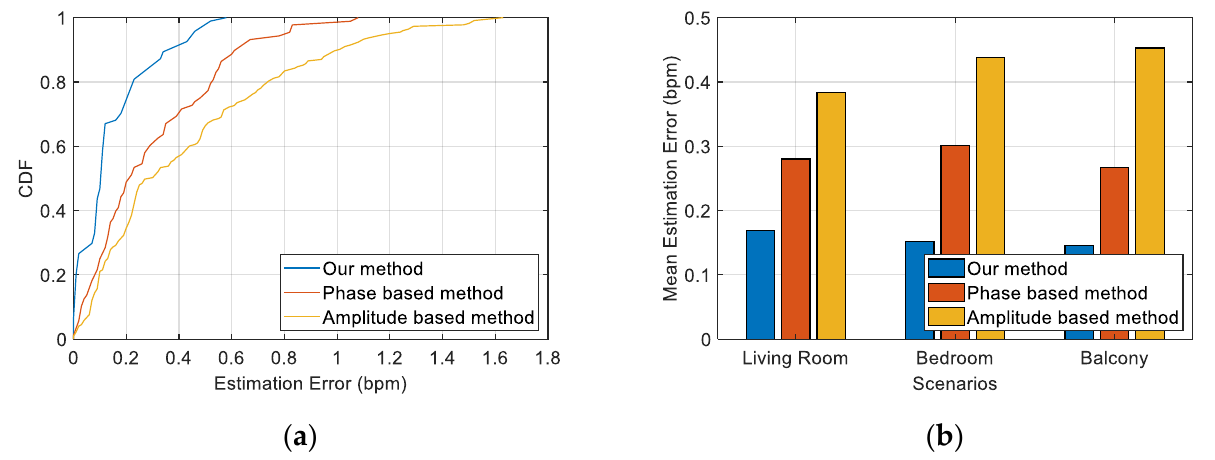
Figure 12. Performance of our method and two benchmark methods (amplitude-based and phase-based). ( a ) CDF of the estimation error of the three methods in the bedroom scenario. ( b ) Mean estimation error of the three methods in the living room, bedroom and balcony scenarios.